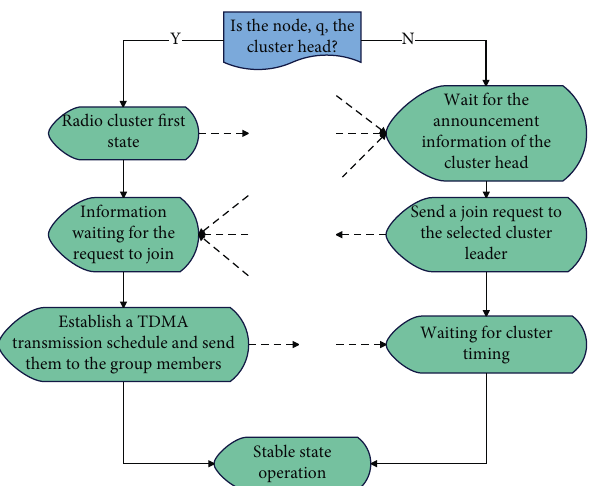
Figure 2: Flowchart of LEACH clustering algorithm.